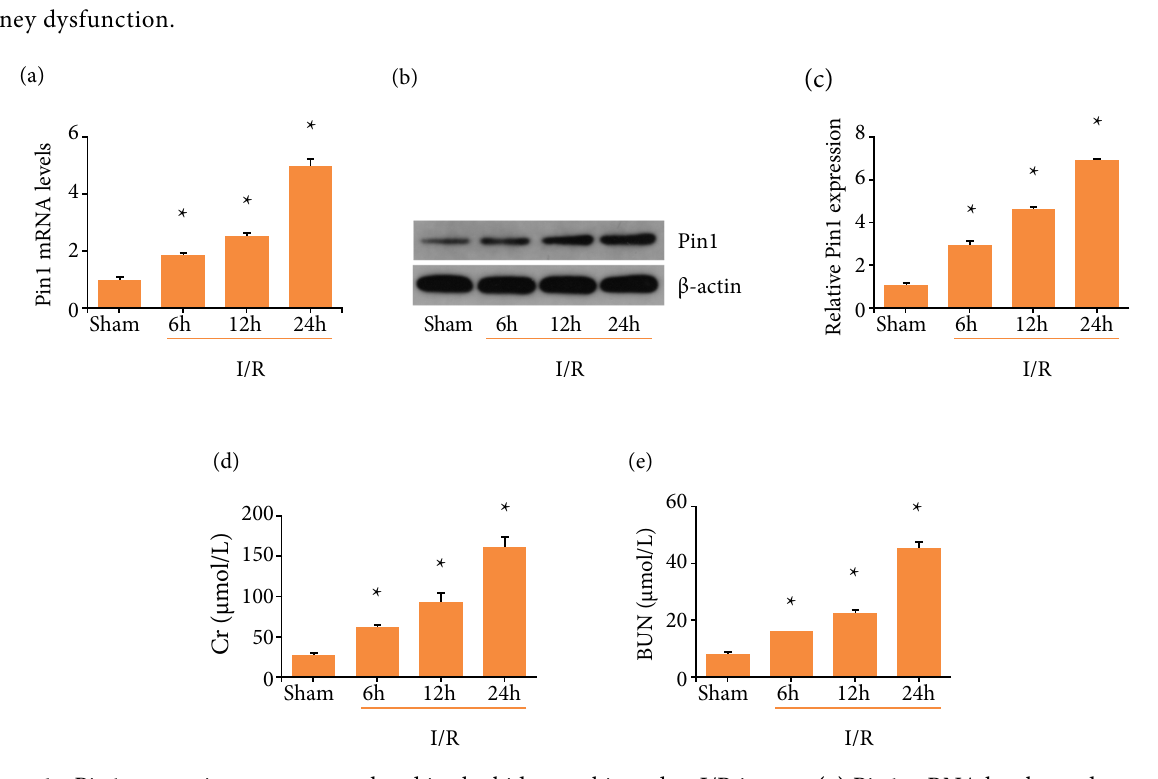
Figure 1 - Pin1 expression was up-regulated in the kidney subjected to I/R in rats. (a) Pin1 mRNA level was detected by RT-PCR after ischemia 45 min and reperfusion 6, 12 and 24 h, respectively. (b, c) Pin1 protein level was detected by western blot and the quantification was performed. (d, e) Serum Cr and BUN level were detected after